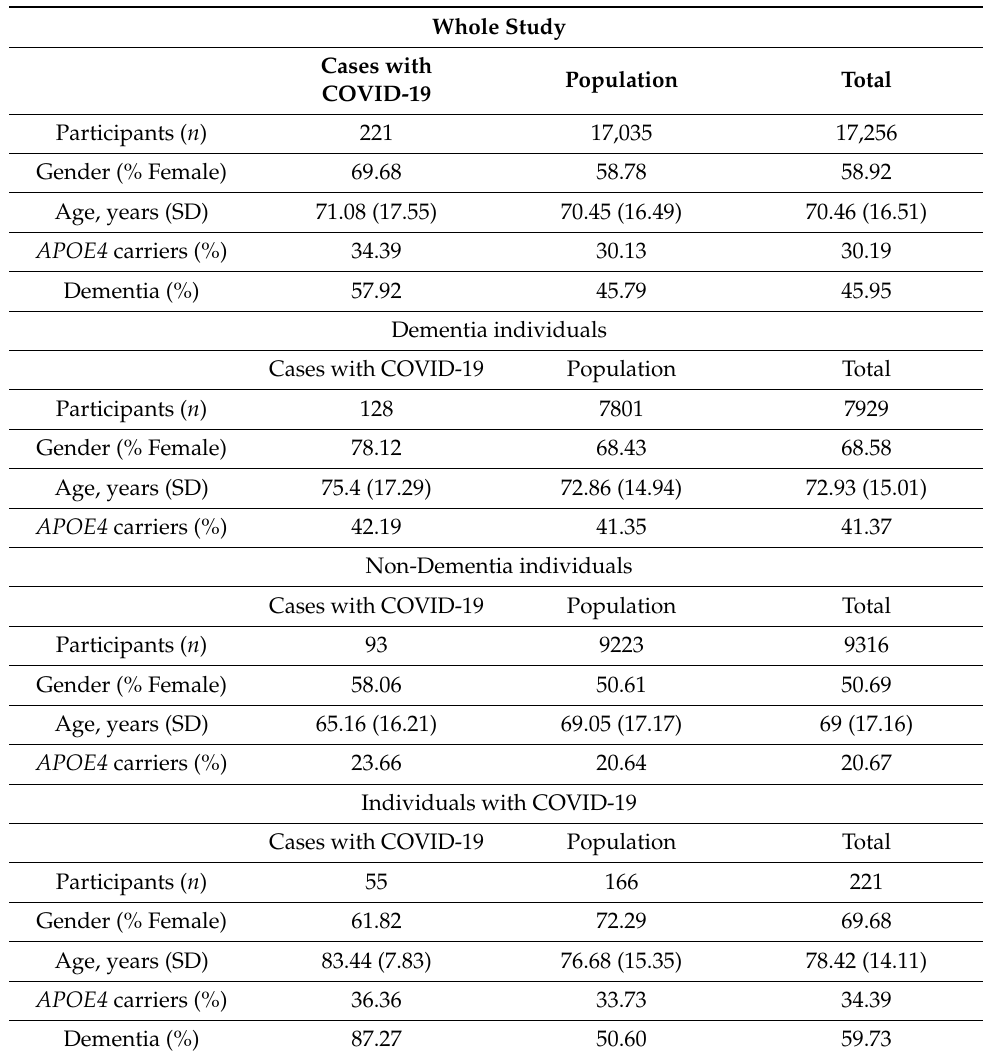
Table 1. Demographics of the GWAS models in GR@ACE/DEGESCO